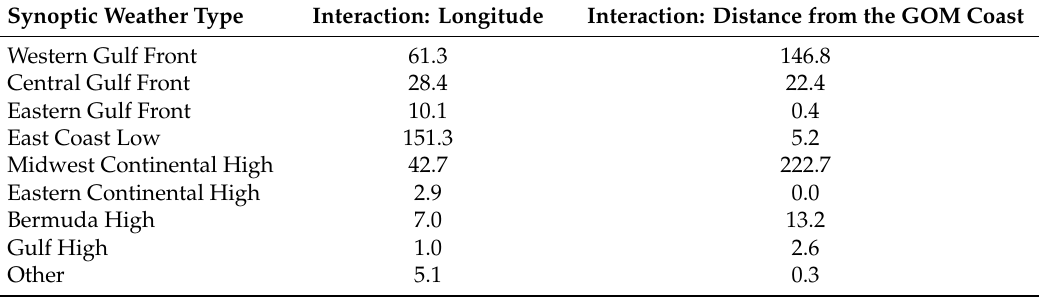
Table 1. The strength of two-way interactions among selected predictor variables indicated by the boosted regression tree model, with each synoptic weather type as an individual predictor variable and mean vertically-integrated reflectivity as the response variable. The full set of predictor variables included longitude, distance from the Gulf of Mexico (GOM) coast, en route synoptic weather type encountered during migration over the Gulf of Mexico, and the proportion of hardwood forest within 5 km, distance from the radar, and relative